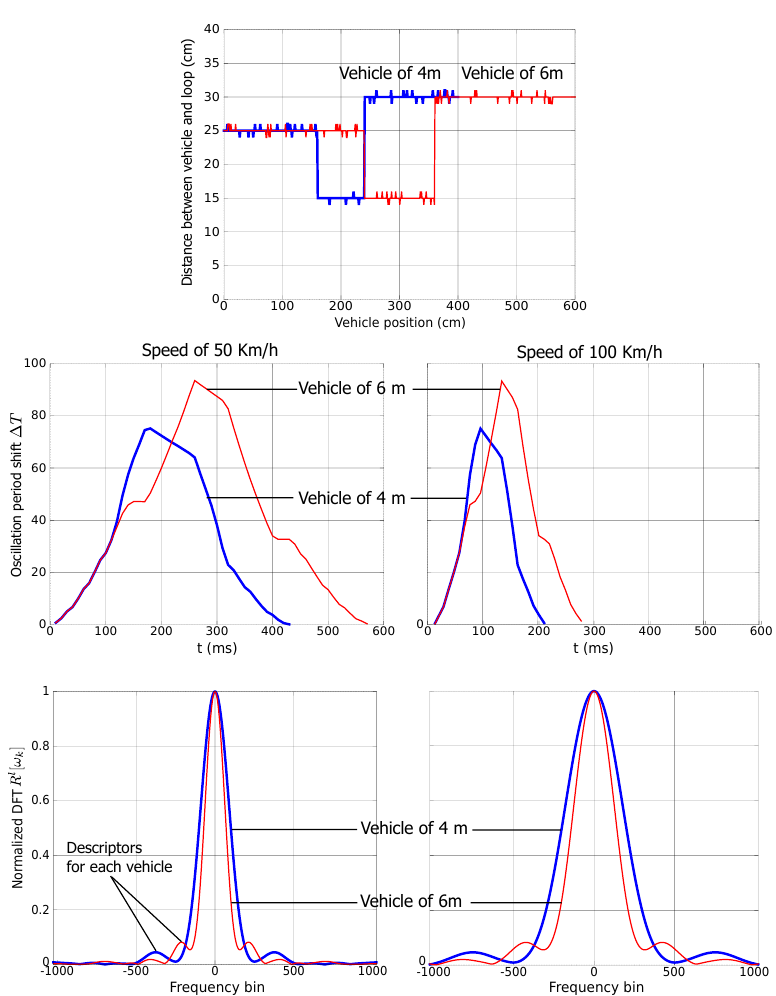
Figure 2. Software simulator: Examples of profiles ( Top ), signatures ( Middle ) and normalized DFT ( Bottom ) for two vehicles of 4 m and 6 m in length and for different speeds.